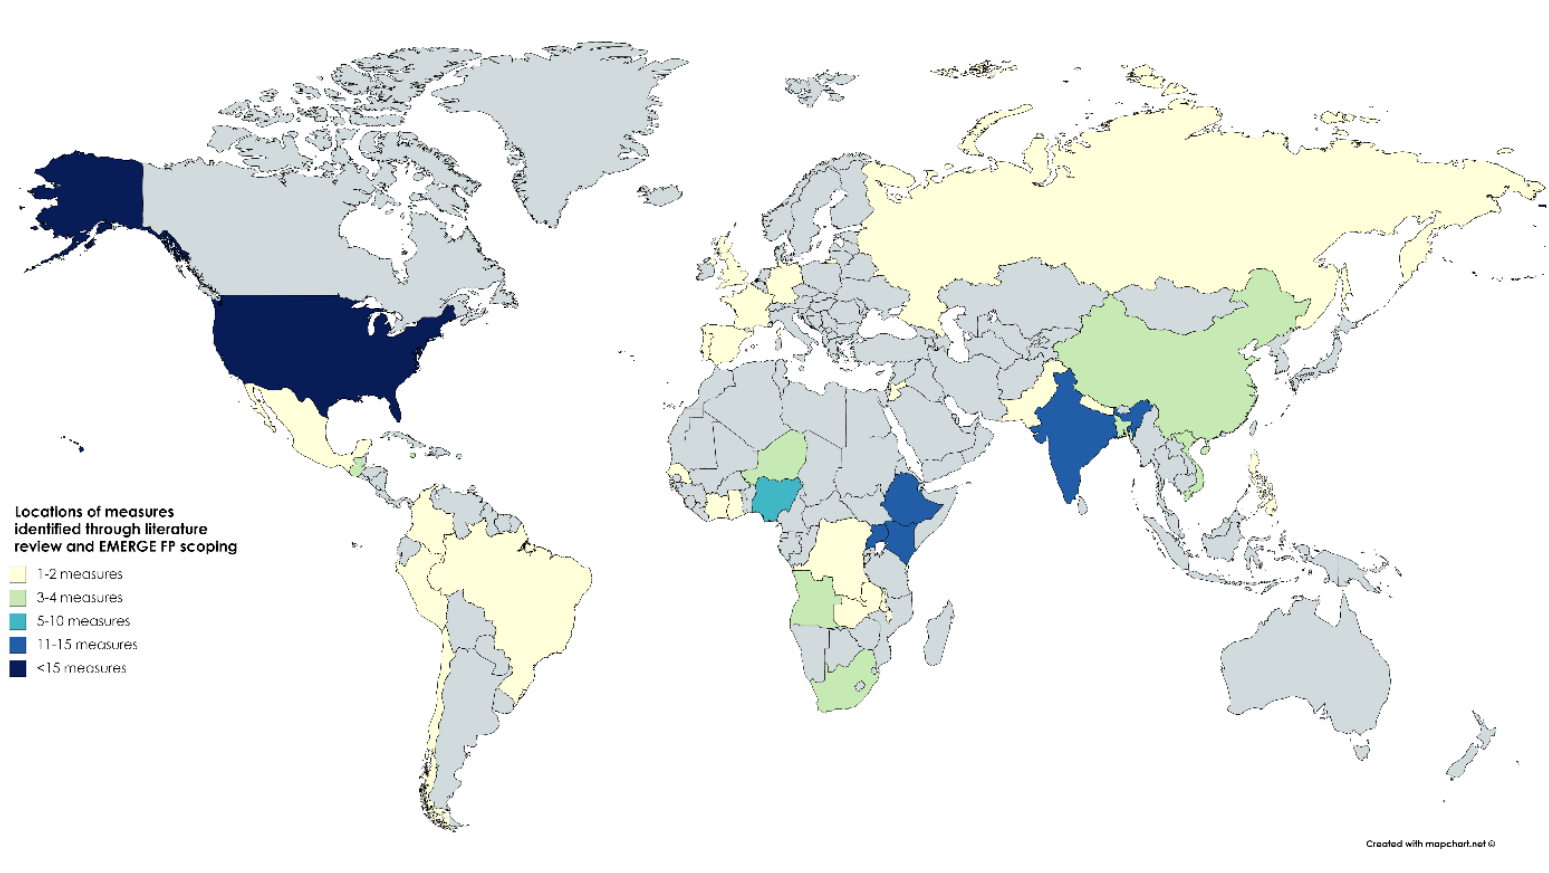
Figure 1a: Geographical distribution of measures of gender equity in family planning